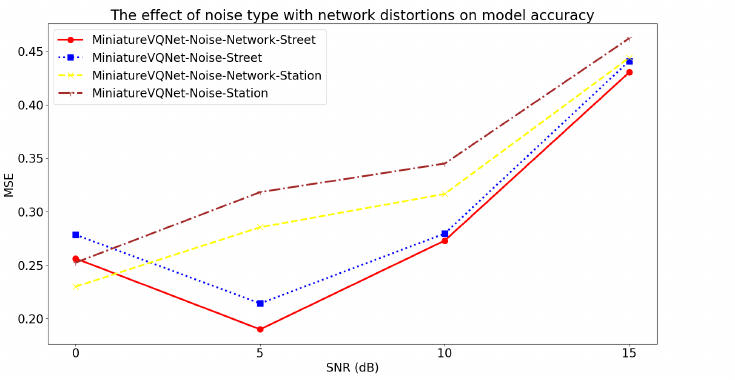
Figure 5. Effect of noise type on prediction